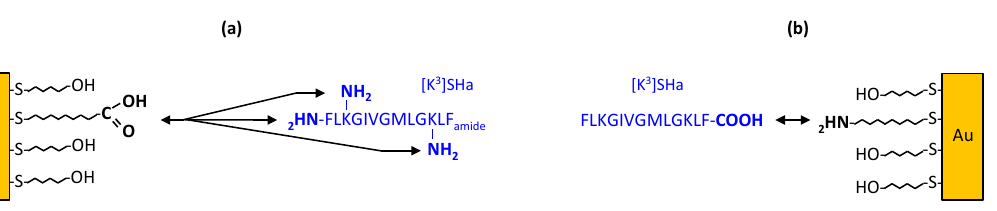
Figure 1. Different grafting strategies of SHa analogs. ( a ) Grafting of C-terminal α -carboxamidated SHa analogs on carboxylic acid-terminated MUA SAMs. ( b ) Grafting of free C-terminal carboxylate SHa analogs on amine-terminated MUAM SAMs. Reactive functions of the MUA/MUAM SAM and of [K 3 ]SHa are indicated in bold.